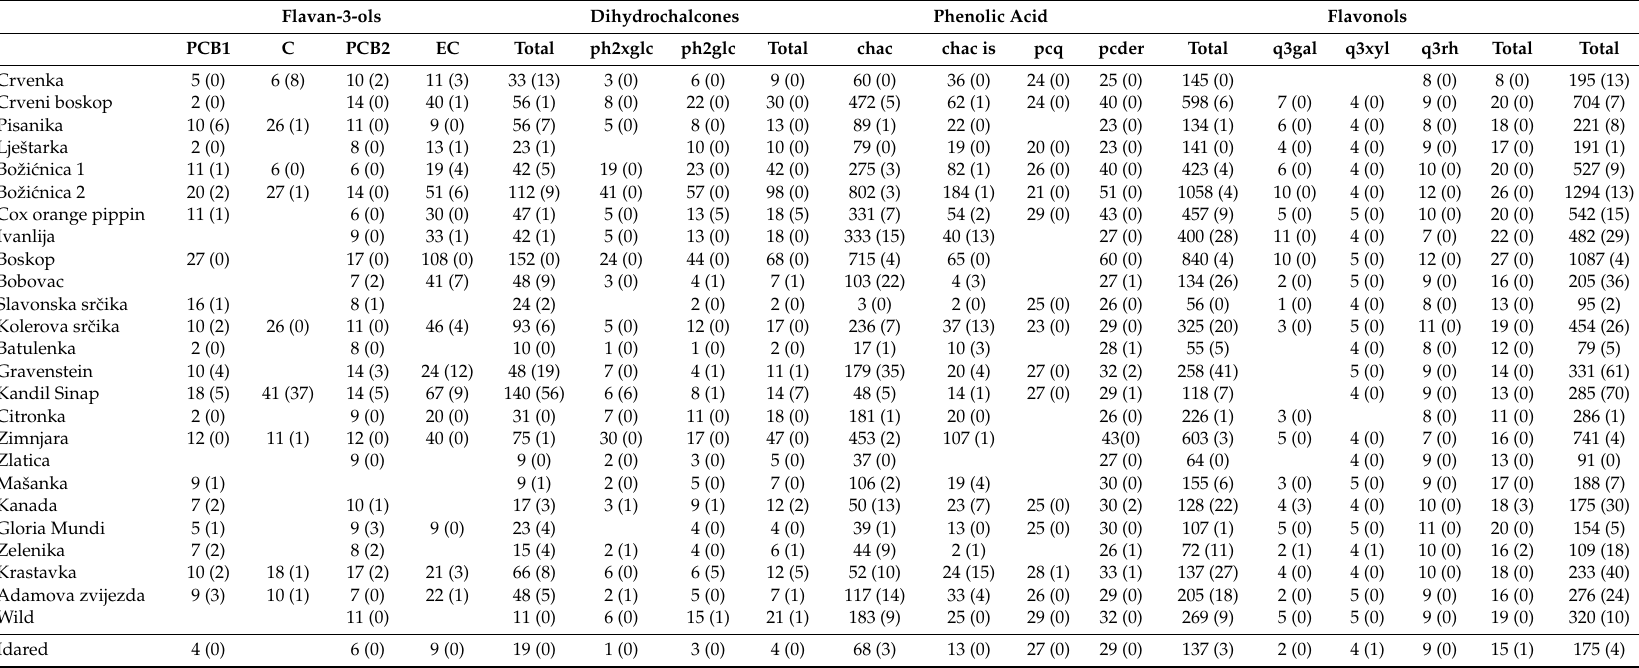
Table 3. The amount of polyphenols in the flesh of old apple varieties (mg kg − 1 fresh